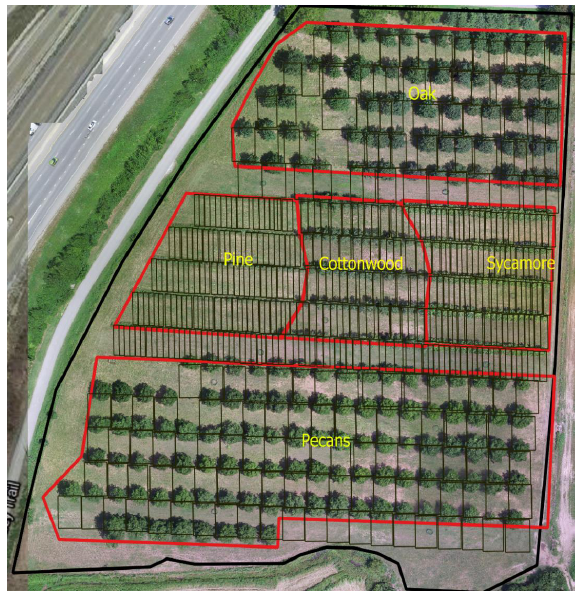
Figure 1. Study site with tree species labels (oak, pine, cottonwood, sycamore, and pecans) and area representing the individual tree polygons. Tree polygons extend southbound to identify grass species treatments (planted in tree alleys) associated with each individual tree.